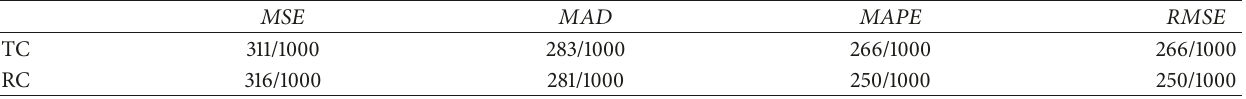
Table 8: Number of paths for which measures of error are higher for monthly steps than for annual steps in MR-OUP 5-Steps MC simulation.